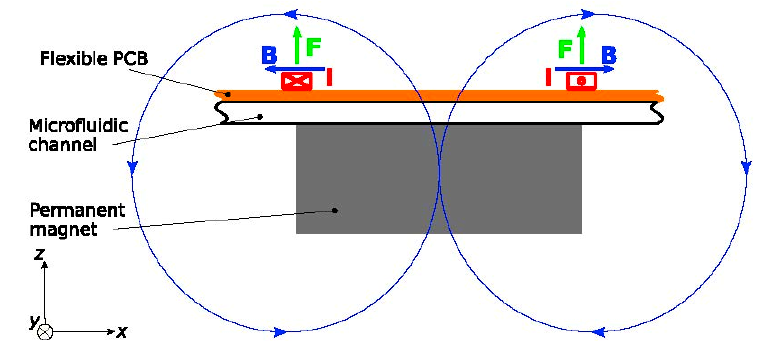
Figure 3. Principle of actuation. A cut-plane through the length dimension is depicted. Red: Copper traces with indicated current direction. Blue: Magnetic field lines and direction of the magnetic induction ( B ) at the position of the traces. Green: Forces acting on the traces, F = I ( l × B ).